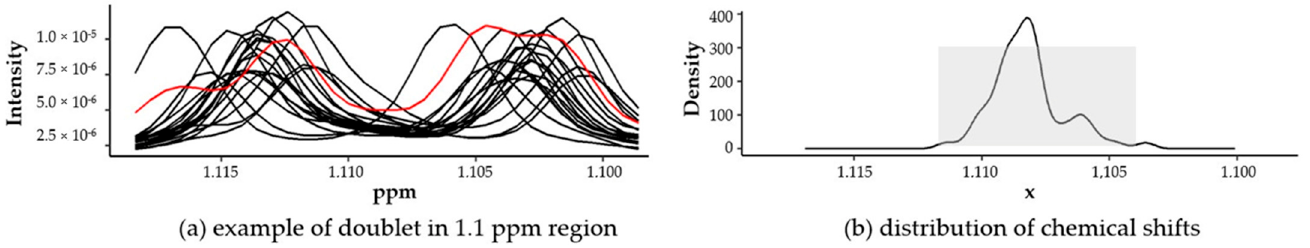
this signal ( a ) forces lineshape fitting algorithms to consider a wide range (light grey rectangle) of possible chemical shift values during the fitting ( b